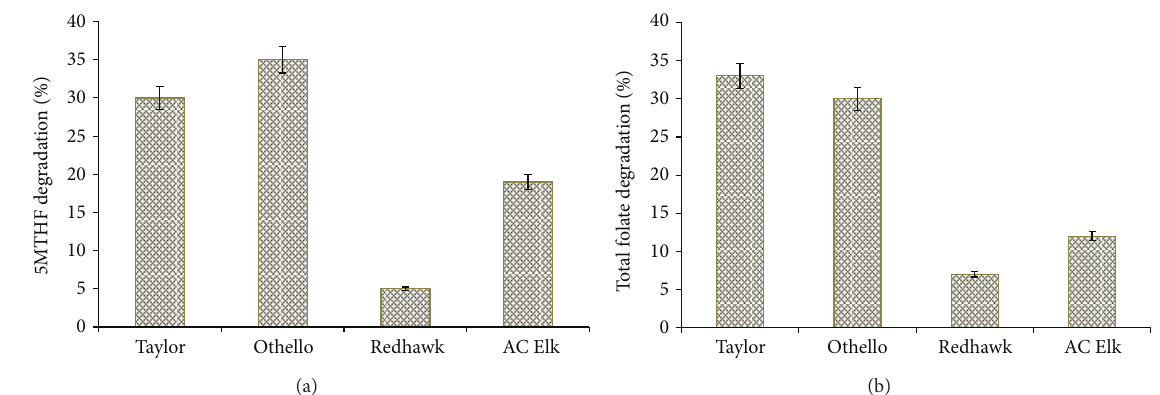
Figure 1: Instability of 5-methyltetrahydrofolate (5MTHF) (a) and total folate (b) contents estimated as the proportion of folate content lost in the one-hour time interval between two High Pressure Liquid Chromatography measurements in four dry bean